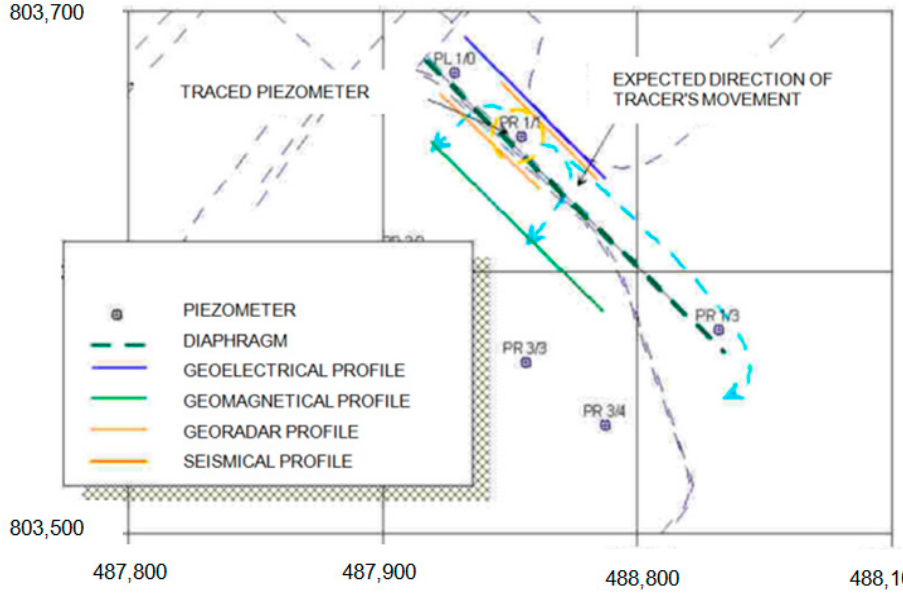
Figure 9. Disposition during tracing monitoring—piezometer PR1/1 [13].